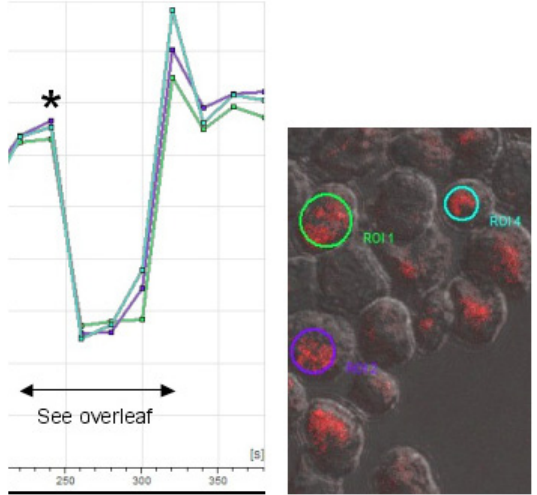
Fig. 6. Responses of Ru nanoparticles within MCF-7 cells in an anaerobic suspension (gas phase N 2 ) held in a hanging drop of growth medium to a one minute pulse of air. Time depen- dencies of intensities of emission from selected areas corre- sponding to three cells of the confocal image are indicated.